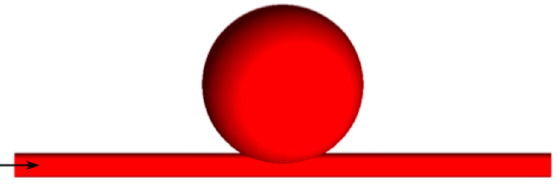
Figure 1. Idealized model of an idealized saccular giant brain aneurysm.